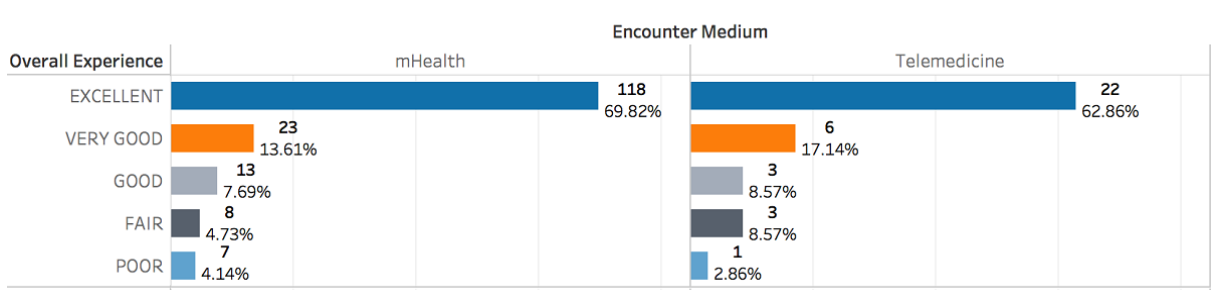
Figure 2. Self-reported overall experience satisfaction ratings. mHealth: mobile